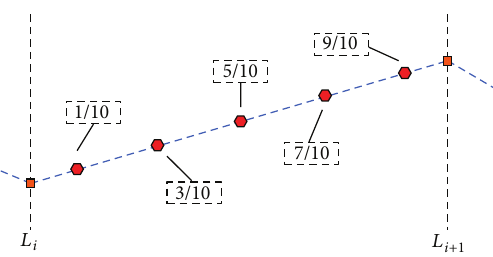
Figure 2: Schematic diagram of flight cost